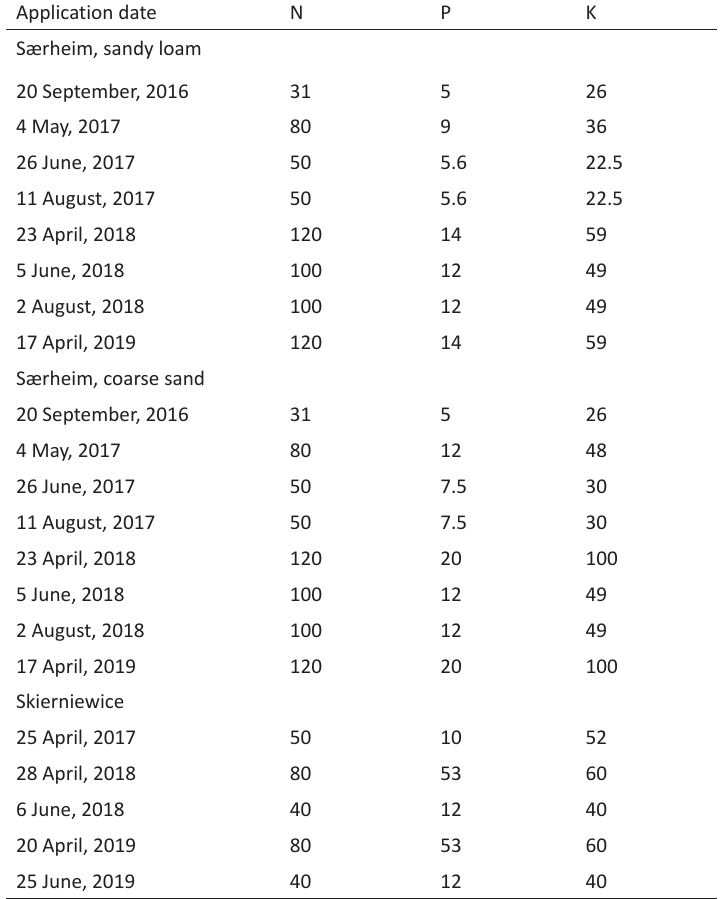
Table 2. Content of nitrogen (N), phosphorus (P) and potassium (K) in applied mineral fertilizers (kg ha -1